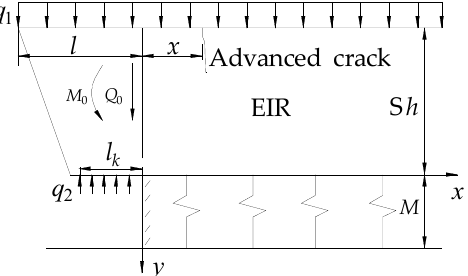
Figure 4. Mechanical model of EIR elastic foundation beam and the EIR suspension elongation is l .